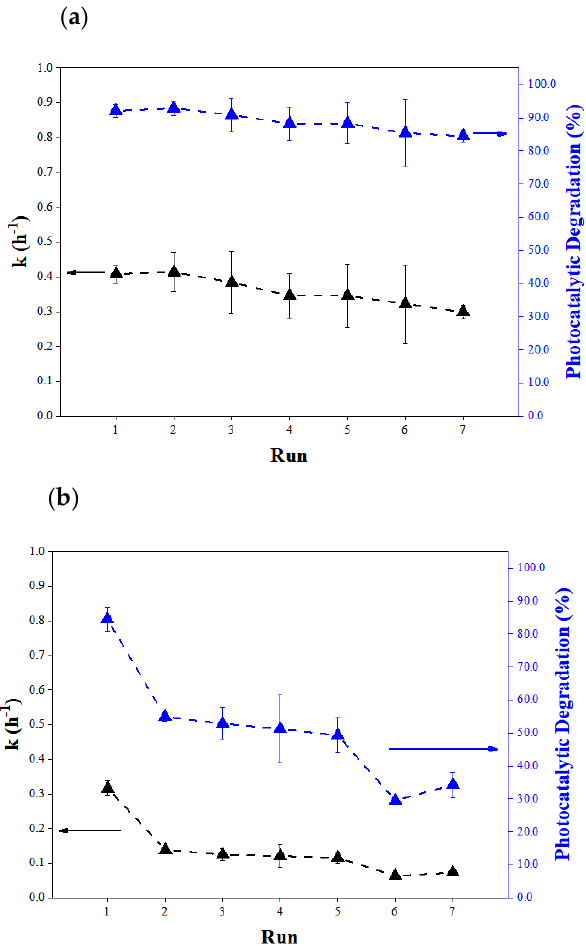
Figure 9. ( a ) Photocatalysis kinetics and degradation percentage for annealed samples over seven runs; ( b ) photocatalysis kinetics and degradation percentage for nonannealed samples over seven runs.